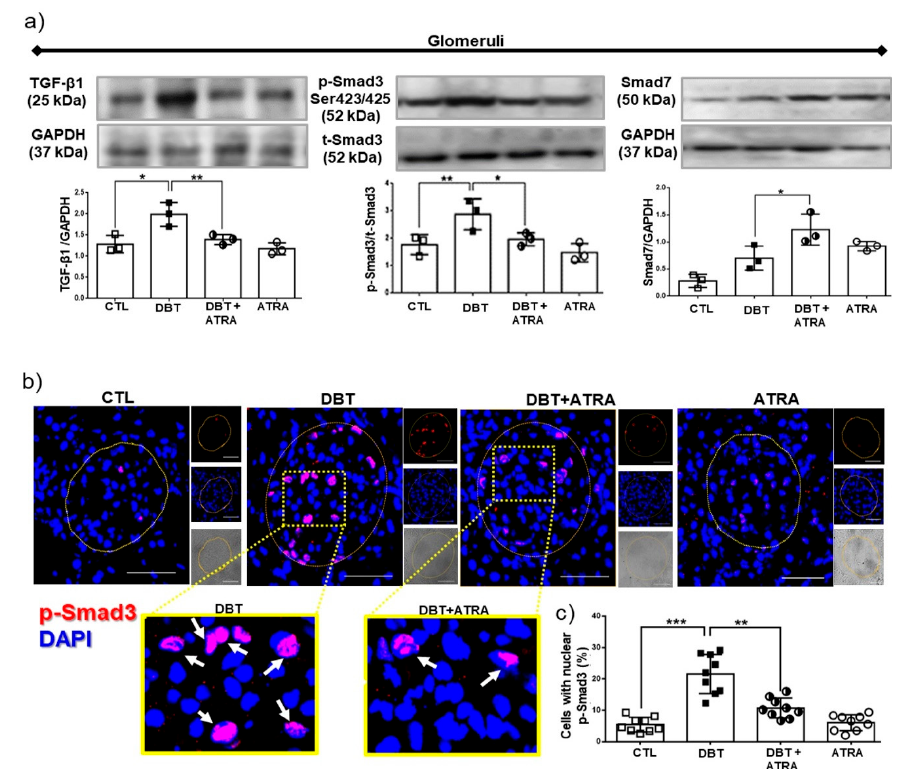
Figure 6. All-trans retinoic acid (ATRA) blocked activation of transforming growth factor (TGF- β 1)/Similar mothers against dpp3 (Smad3) signaling pathway in glomeruli of diabetic rats. ( a ) Western blot analysis of TGF- β 1, Smad3 phosphorylated (pSmad3) and Smad7 in isolated glomeruli of the four experimental groups, ( b ) confocal microscopy analysis for cellular localization of pSmad3 (red label) in renal sections. Nuclei were counterstained with 4 (cid:48) ,6-diamidino-2-phenylindole (DAPI, blue label), and ( c ) quantification of pSmad3 nuclear translocation. ATRA treatment downregulated diabetes-induced TGF- β 1 and Smad3 expression by increased Smad7. Furthermore, ATRA inhibited the nuclear translocation of pSmad3 in glomerular cells. Results are expressed as the percentage of the pSmad3 nuclei-positively stained cells into glomeruli. Glyceraldehyde 3 phosphate dehydrogenase (GAPDH) was used as loading control. Data are representative of three independent experiments, and values are expressed in mean ± SD. * p < 0.05, ** p < 0.01, *** p < 0.001. The scale bar is equal to 50 µ